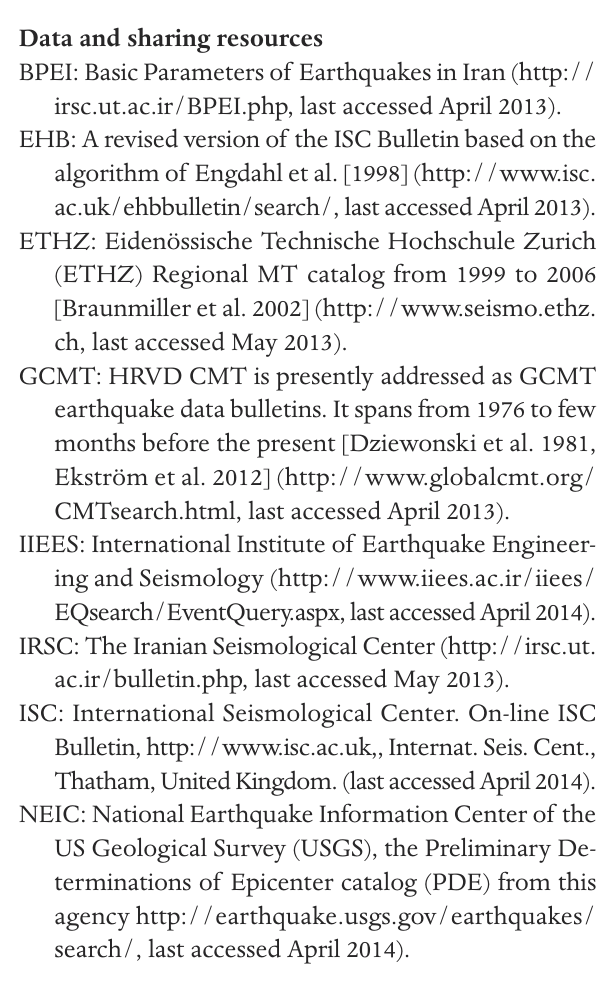
) for instrumental earth- c